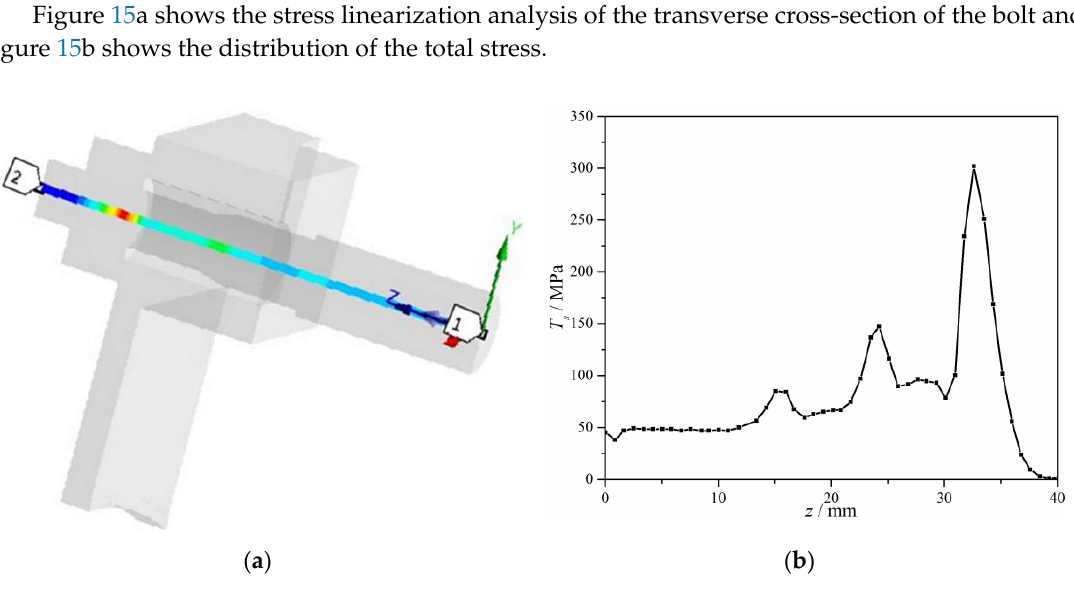
Figure 15. The path of the stress linearization analysis and the stress distribution along the path: ( a ) The path of the stress linearization analysis; and, ( b ) The stress distribution along the path.